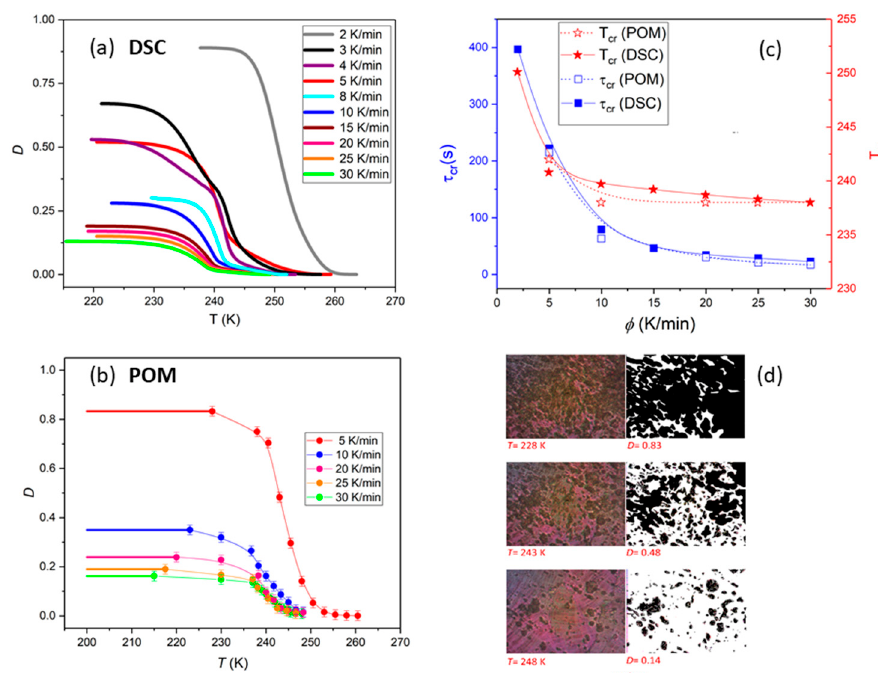
Figure 1. Differential scanning calorimetry (DSC) thermograms of 4-n-butyloxybenzylidene- 4 ′ -n ′ -octylaniline (BBOA) obtained at various rates of cooling ( a ) and heating ( b ). ( c ) MDSC thermogram of BBOA obtained for a heating rate 3 K min − 1 with a modulation amplitude of 0.5 K for a period of 60 s. ( d ) Exemplary textures of BBOA in various mesophases as indicated.